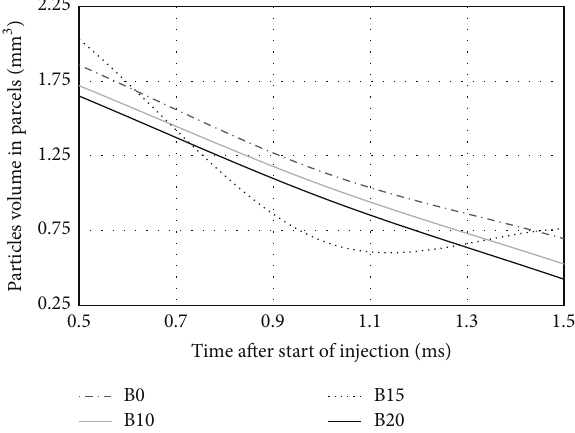
Figure 13: Liquid phase spray length of different HFO/n-butanol blends at injection pressure of 600bar.